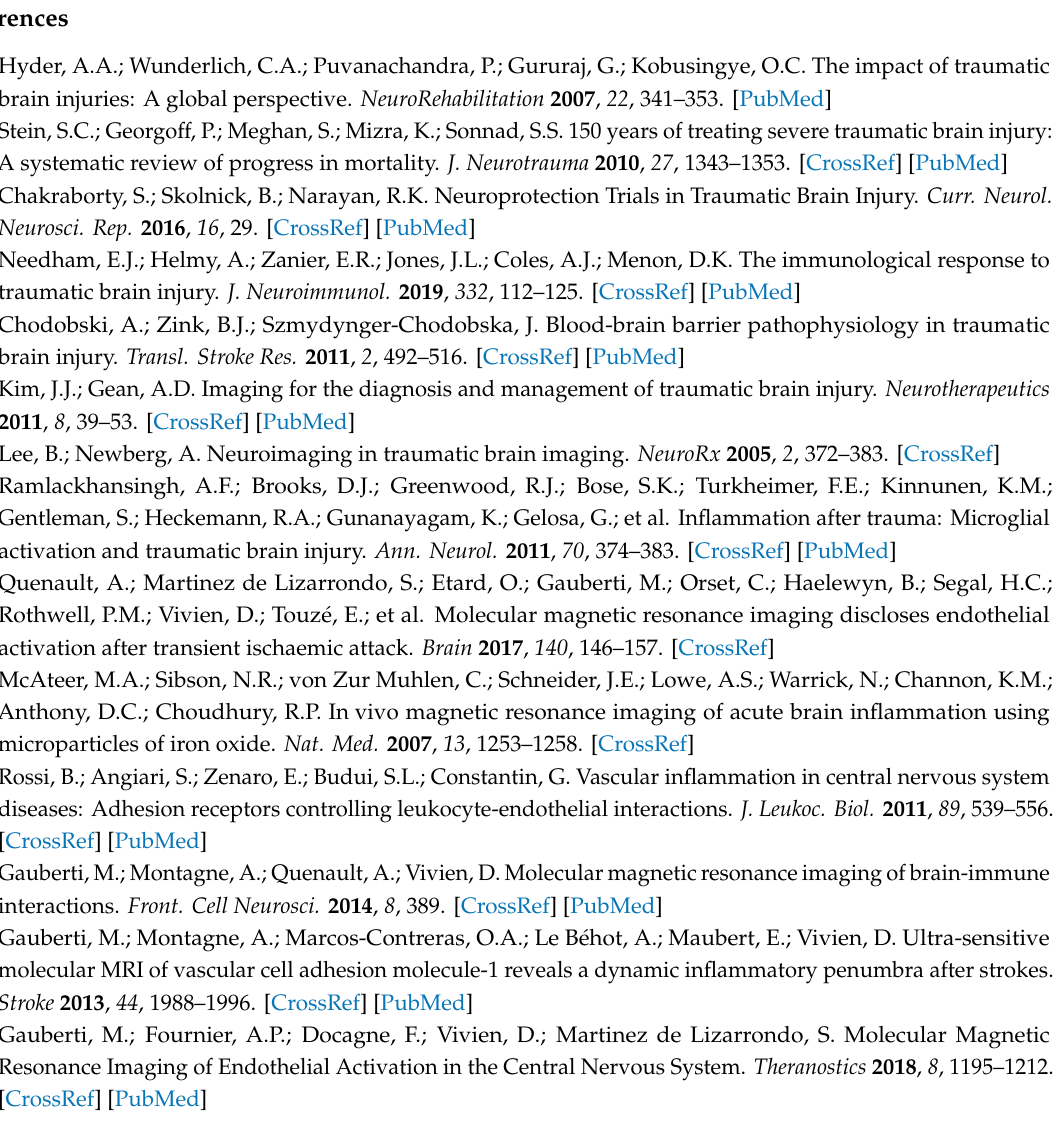
Figure S1: Sham animal injected with MPIOs- α -P-selectin. Representative coronal slices (A.P.: 0, − 1, − 1.6, − 2 mm from bregma) of a sham showing negligible signal voids 10 minutes after MPIOs- α -P-selectin injection. Figure S2: Spatial distribution of microglia / macropahges in relation to P-selectin 2 days post-TBI in the contralateral hemisphere. Representative micrographs of P-selectin, CD68, IBA1, and CD68 / IBA1 in contralateral cortex (a) and hippocampus-thalamus (b). The white dotted line defines the border between the hippocampus (upper part of the image) and the thalamus (lower part of the image), as shown in the sketch. Negligible P-selectin or CD68 staining was detected in the contralateral hemisphere. Scale bar 50 µ